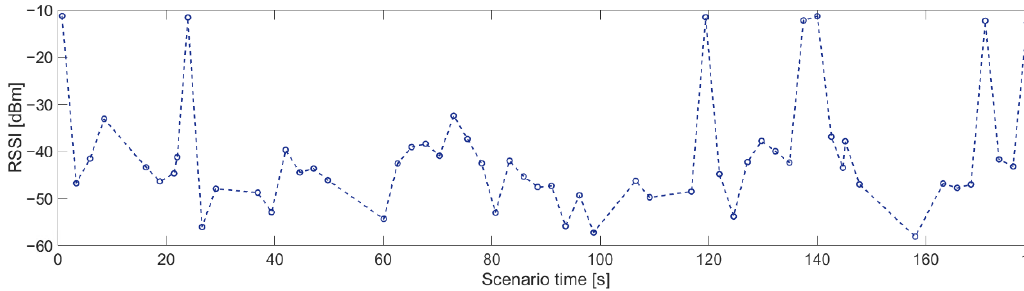
Figure 19. RSSI level for relationship 4 and 3.